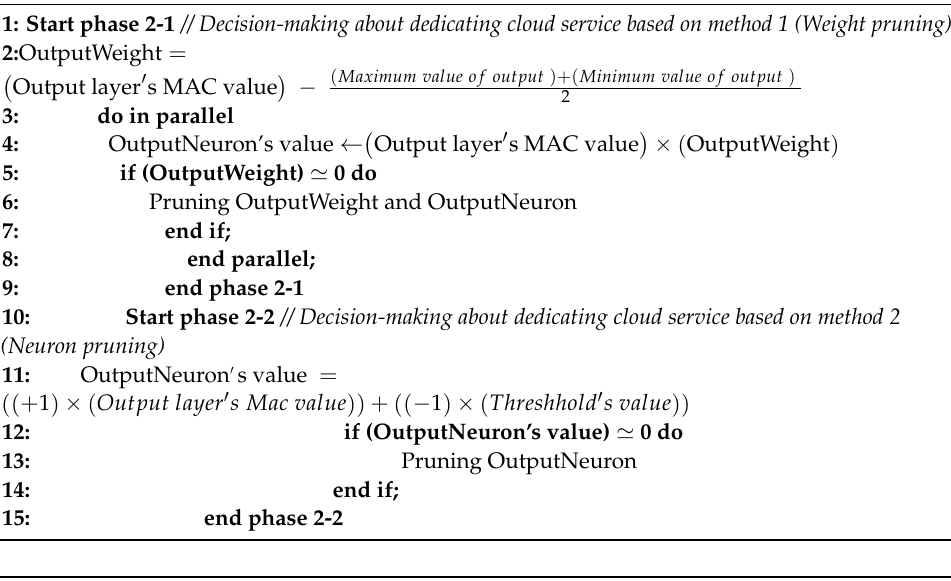
Algorithm 3. Quasi-mapping and availability-aware Cloud service’s(QAC)3-1;